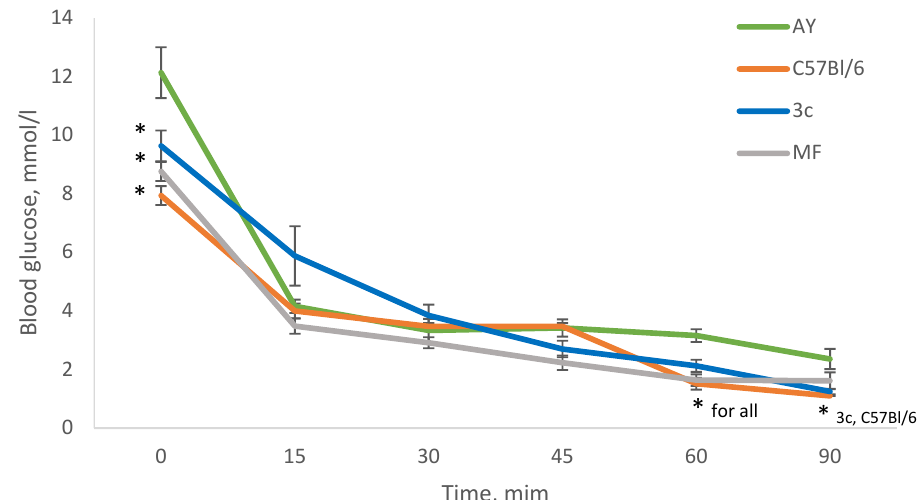
Figure 6. Blood glucose levels in ITT performed 29 days after the beginning of the experiment. * p < 0.05 as compared to AY mice.